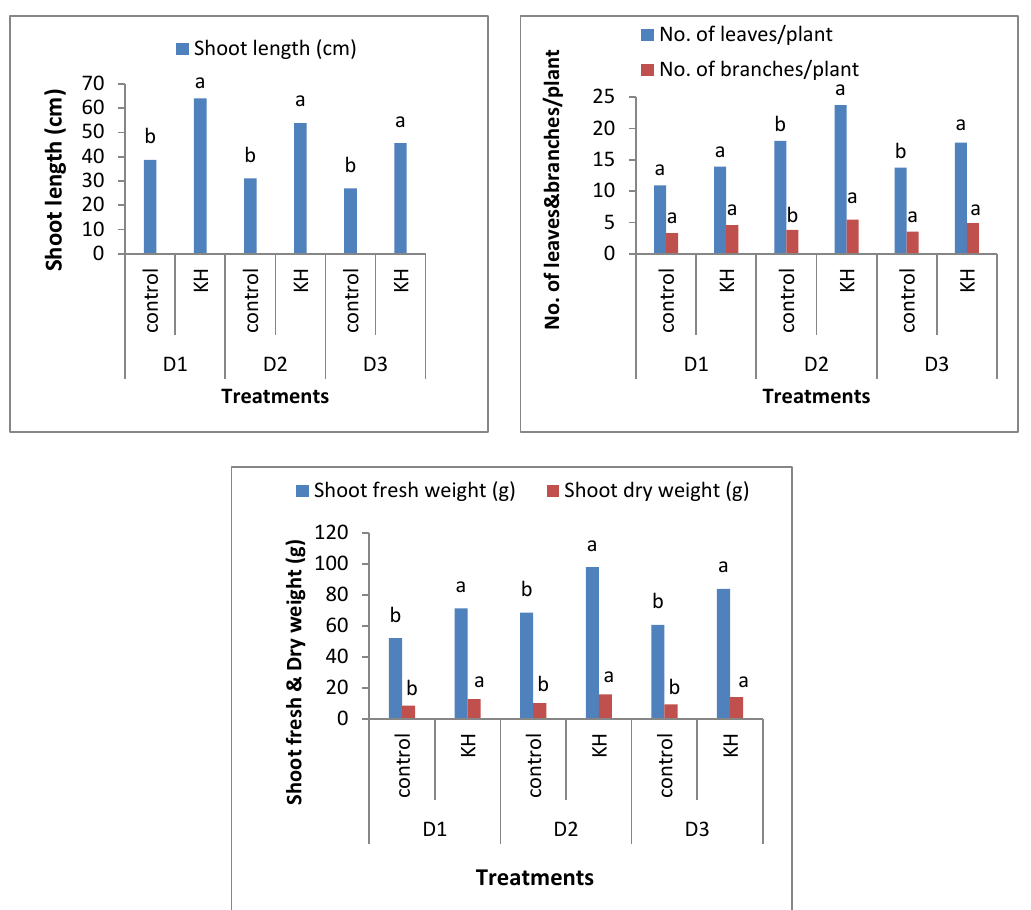
Figure 1. Effect of potassium humate (KH) application and planting density treatment on shoot length (cm), no. of leaves/plant, no. of branches/plant, shoot fresh weight (g) and shoot dry weight (g) of Vicia faba L. plants. For each parameter, treatments followed by the same letter are not significantly different at p ≤ 0.05.